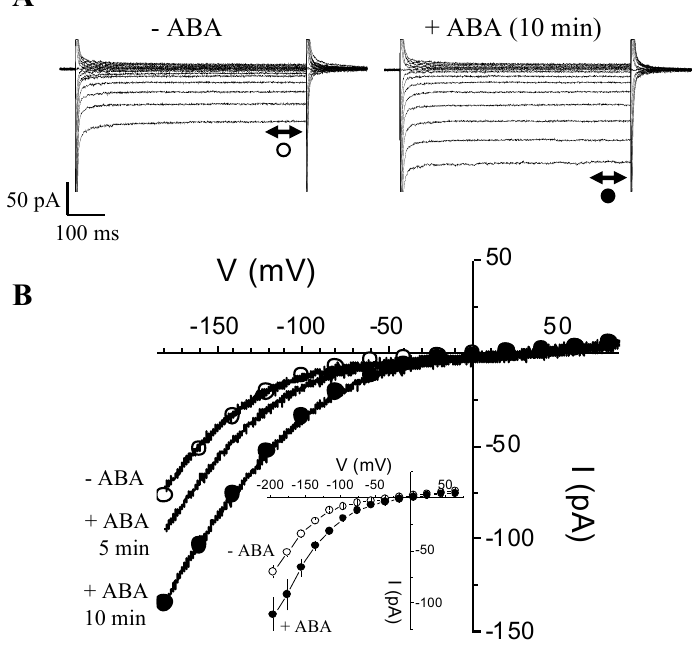
Figure 5. Rapid enhancement of I Ba by abscisic acid (ABA). ( A ) The I Ba currents in the absence of Mg-ATP in the patch pipet recorded from the same guard cell in response to hyperpolarizing voltages (from +64 to − 196 mV; in − 20 mV increments) before ( ○ ) and 10 minutes after ( ● ) bath application of ABA (20 µM). ( B ) I–V plots of the effect of ABA, showing the enhancing effect of ABA with time (control: -ABA; 5 and 10 minutes after continuous bath perfusion with ABA). We also superimposed the measurements generated by voltage ramps for the control, 5 and 10 min ABA. Inset: Superimposed I-V plots showing the average effect of ABA on I Ba (0 Mg-ATP). Data are current average measurements (± SEM) from different experiments ( n = 3) before ( ) and approximately 10 minutes after ( ) bath perfusion with ABA (Student’s test; * p ≤ 0.05, ** p ≤ 0.01, ns p > 0.05).